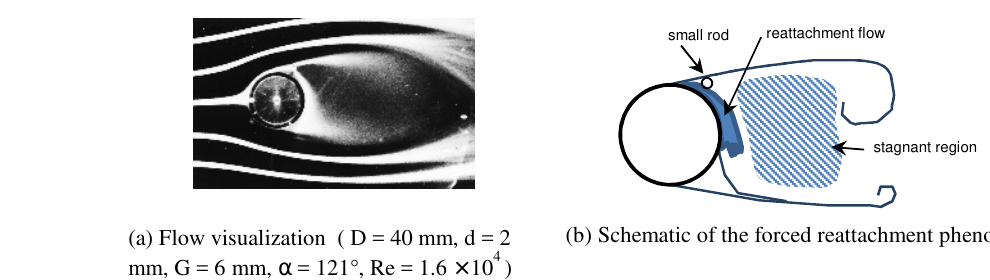
Fig. 1 . Forced reattachment .